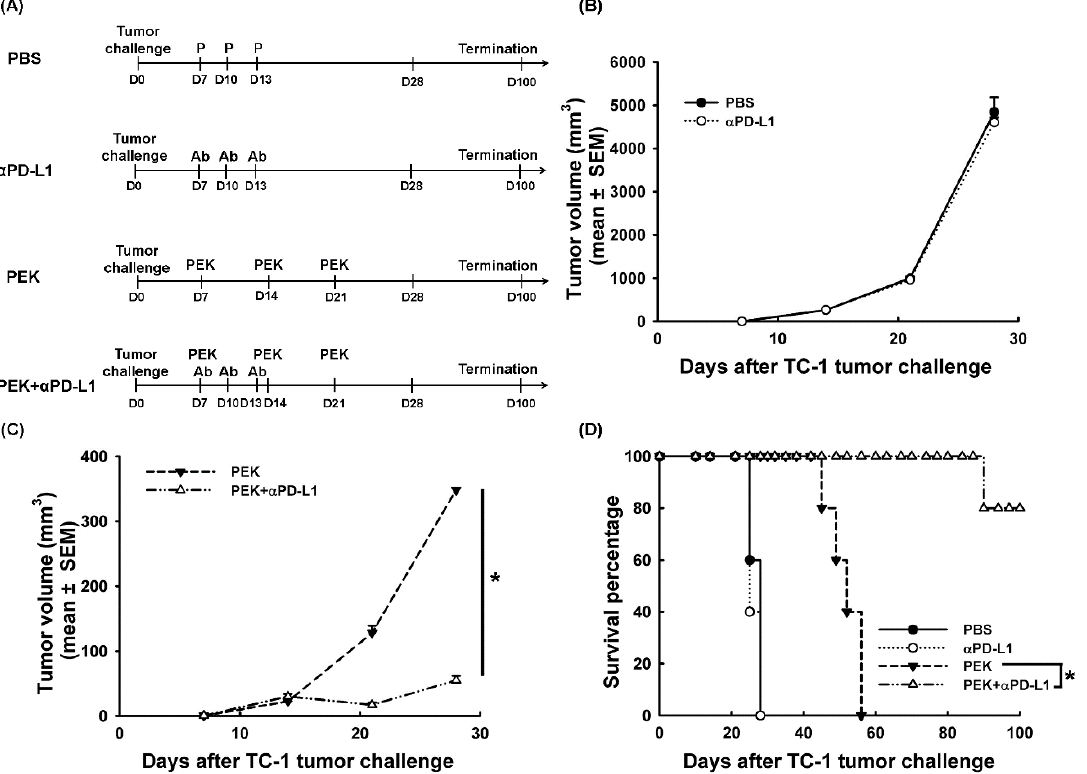
Figure 1. Anti-tumor effects of PEK antigen-specific protein vaccine with or without anti-PD-L1 Ab. ( A ) Diagram of the different regimens of PEK protein vaccine with or without anti-PD-L1 Ab. ( B ) Anti-tumor effects of mice treated with PBS or anti-PD-L1 Ab alone. Anti-tumor effects were not improved in tumor-bearing mice treated with anti-PD-L1 Ab alone ( p = 0.86, Student’s t -test). ( C ) Anti-tumor effects of mice treated with PEK protein vaccine with or without anti-PD-L1 Ab. Tumor volumes were significantly lower in mice treated with the PEK protein vaccine plus anti-PD-L1 Ab than in mice treated with the PEK protein vaccine plus PBS (*: p < 0.001, Student’s t -test). ( D ) Overall survival of mice treated with PEK protein vaccine with or without the anti-PD-L1 Ab. Eighty percent of mice that received PEK protein vaccination combined with anti-PD-L1 Ab were still alive 100 days after TC-1 tumor challenge. None of the mice receiving the PEK protein vaccine plus PBS survived more than 60 days of tumor challenge (*: p < 0.001, log-rank test). All experiments were performed independently in triplicate (mean ± SEM).